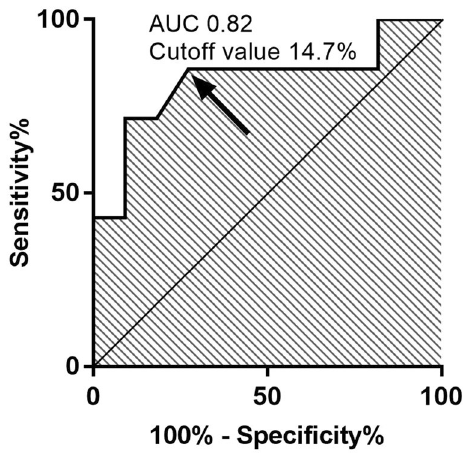
Figure 2. ROC curve for defining the optimal cut-off IgG4/IgG ratio in patients with a single affected organ. The ROC curve for distinguishing IgG4-RD from other diseases in patients with a single organ lesion. The cut- off value was 14.7%, AUC was 0.82, sensitivity was 90.9%, and specificity was 71.4%. AUC area under the curve, IgG4-RD immunoglobulin G4-related disease, ROC receiver operating